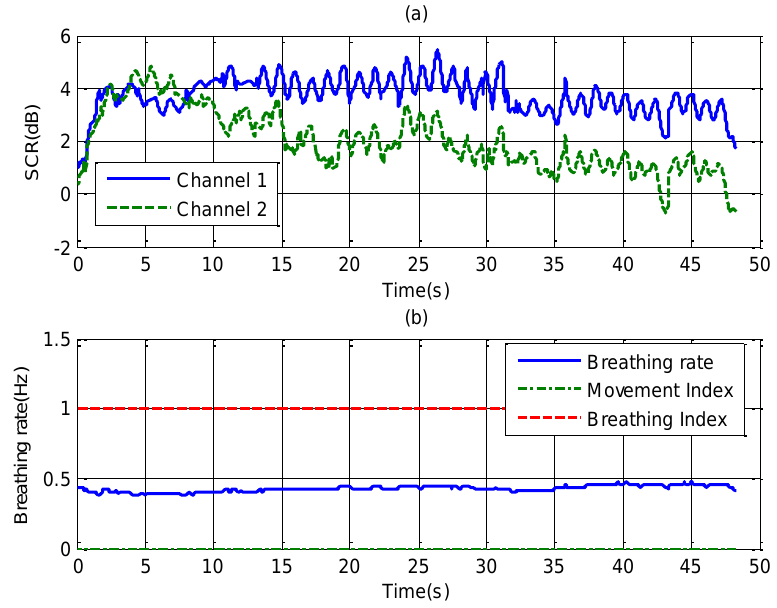
Figure 9. ( a ) Signal to clutter ratio as a function of time for each channel; ( b ) Estimated breathing rate as function of the time (-), movement index (--) and breathing index (-.), for the case of Figure 6a,b.